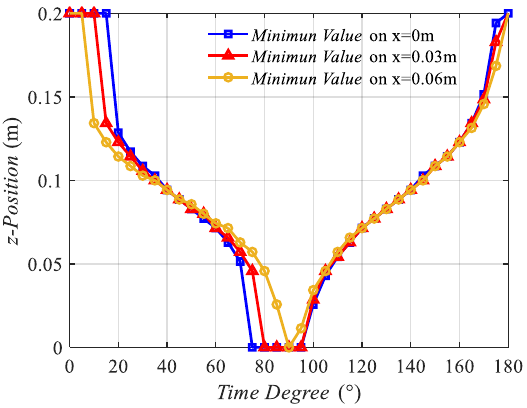
( , , ) H x z t on three middle lines varying with z